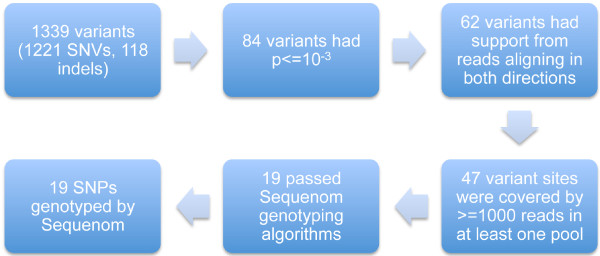
SNP selection scheme.